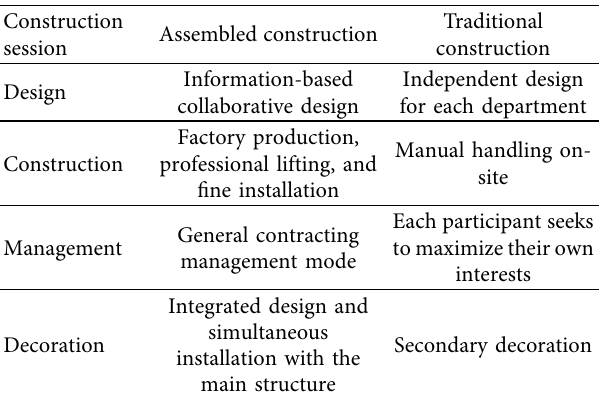
Table 1: Comparison between assembled and traditional constructions.